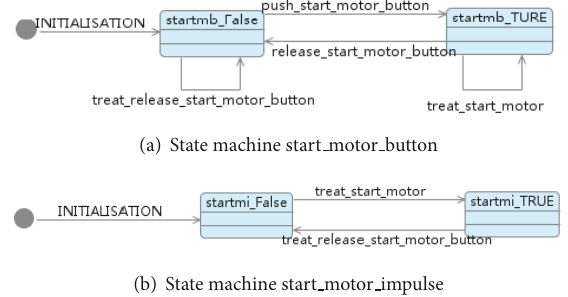
Figure 15: Sub1’s instance state machine.